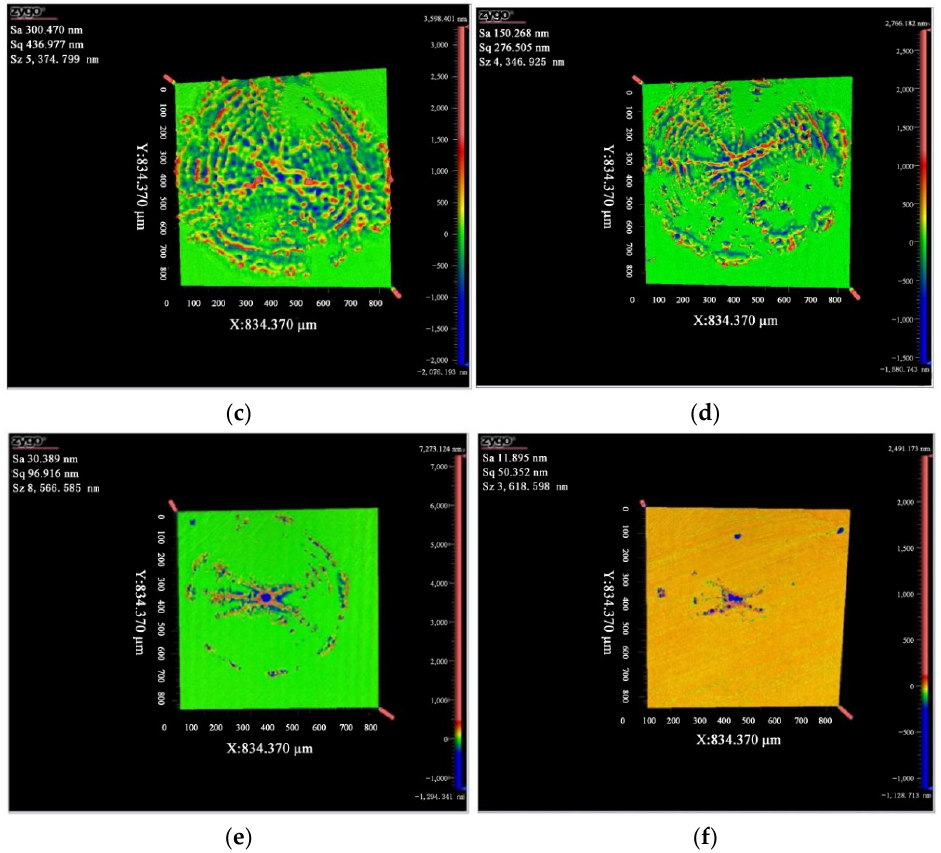
Figure 4. Micro-topography of different laser energy damage. ( a ) 181 mJ (top view), ( b ) 181 mJ (side view), ( c ) 127 mJ, ( d ) 90 mJ, ( e ) 36 mJ, and ( f ) 18 mJ.